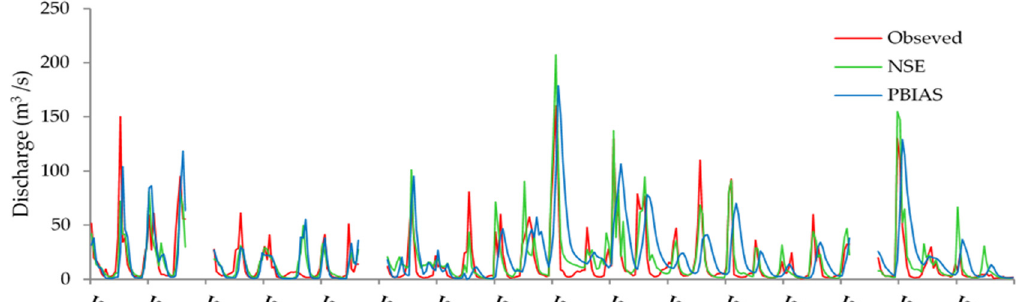
Figure 2. Calibration (1990–2008) and validation (1977–1988) results of monthly simulated discharges showing performance of the best ( NSE ) and the worst ( PBIAS ) objective functions for the T.Karzin station in Salman Dam Basin (SDB).